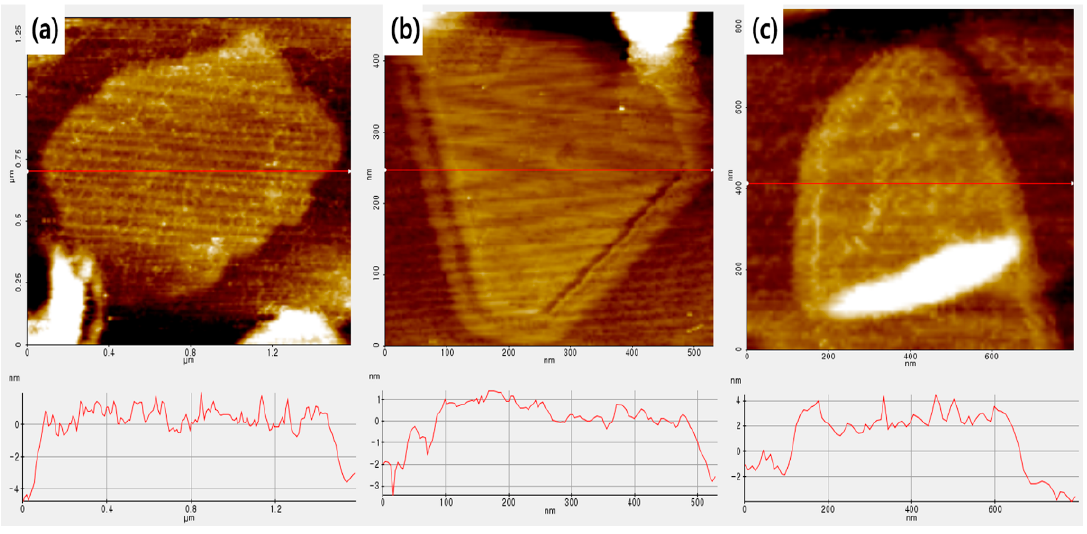
Figure 6. AFM analysis of BNNs–A ( a ), BNNs–B ( b ) and BNNs–C ( c ).